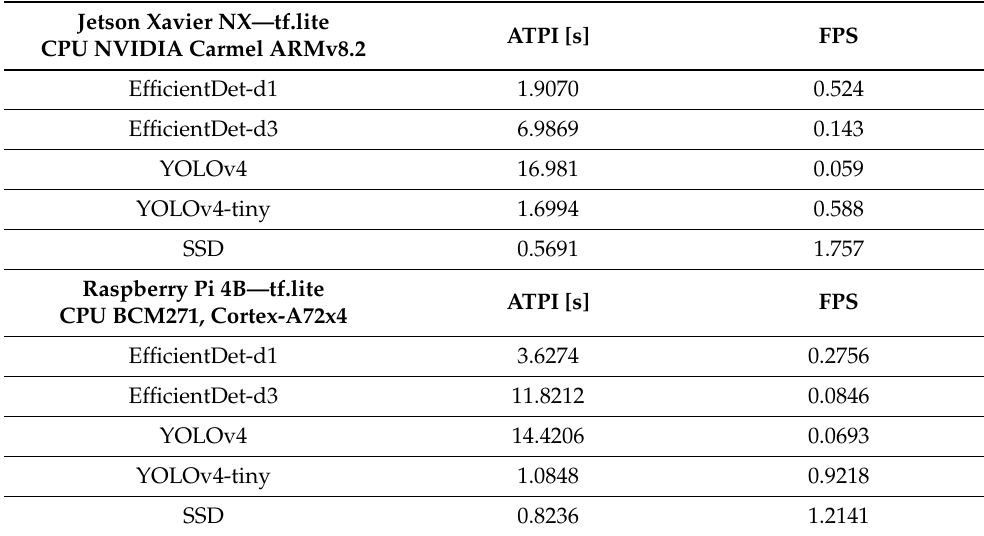
Table 6. Performance result for the Nvidia Xavier NX and Raspberry Pi 4 CPUs. ATPI stands for average time per inference, FPS is frames per